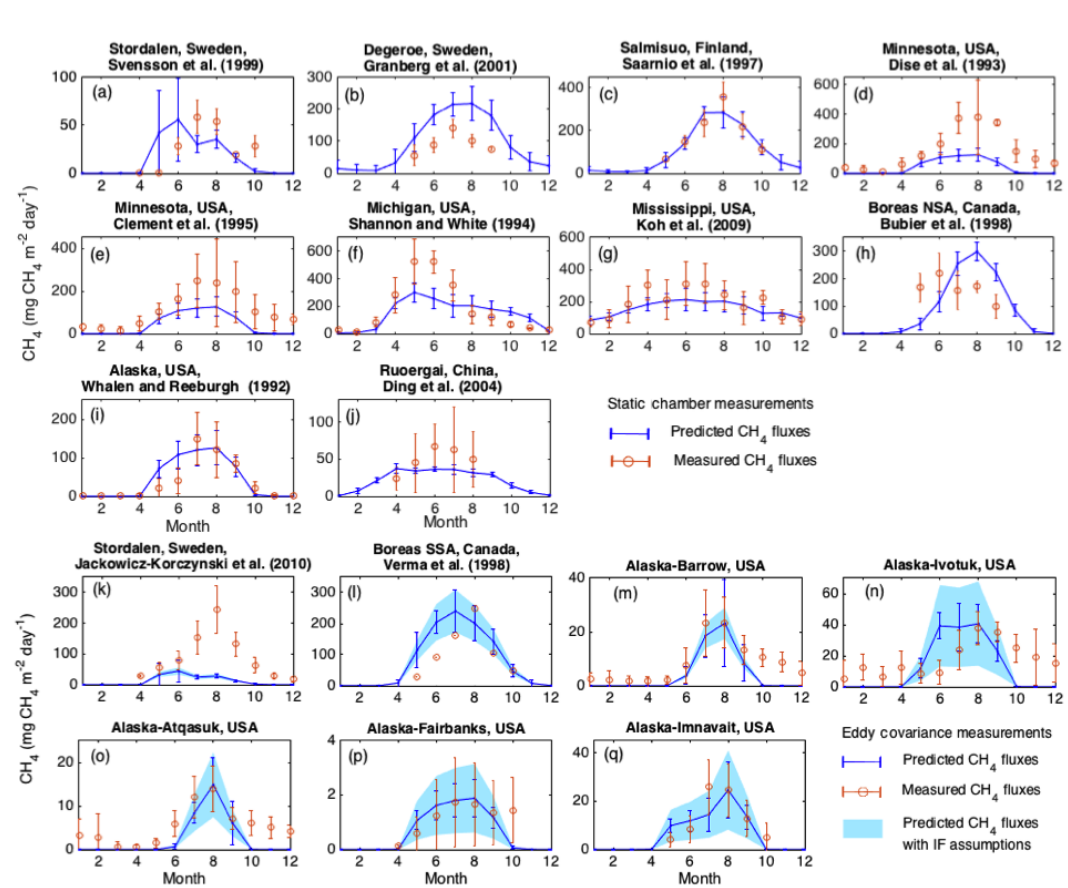
Figure 2. Comparison of monthly mean simulated net CH 4 flux between 2000 and 2012 and observed monthly mean net CH 4 emissions in measurement year(s). The site measurements with static chamber are shown in (a) – (j) , and measurements with eddy covariance (EC) towers are shown in (k) – (q) . The error bars are standard deviation of monthly mean. The measurements with EC tower are weighted with a range of inundation fraction (IF) based on best estimates available: Stordalen – 80–100%; Boreas SSA – 50–90%; Alaska-Barrow – 60–100%; Alaska-Atqasuk – 10–30%; Alaska-Ivotuk – 5–25%; Alaska-Fairbanks – 0.5–2.5%; Alaska-IMN – 5–25%. Detailed description of the sites and measurements are shown in Table